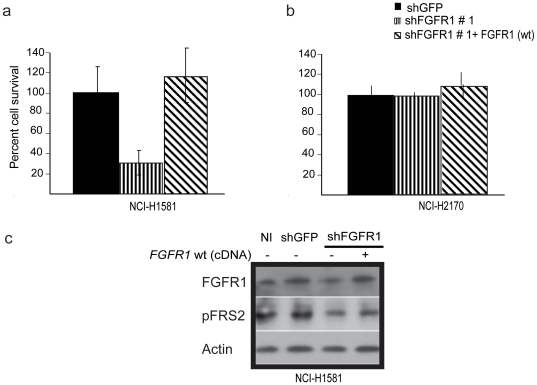
Ectopic expression of FGFR1 coding region rescues lethality of an shRNA targeting the FGFR1 3′ UTR.(A) Bar graph for rescue assay. Lethality due to depleted levels on endogenous FGFR1 level in NCI-H1581 is rescued by over expression of wild type (Wt) full length FGFR1 coding sequence . (B) No effect on the survival of NCI-H2170 cells was observed due to over expression of wild type form of FGFR1. NCI-H2170 is not dependent on FGFR1 activity. NI, no infection. shGFP, control hairpin specific for green fluorescent protein used as a negative control. All results are normalized to survival of cells infected with shGFP. Data shown is as mean of three replicates. (C) Validation of FGFR1 rescue by immunoblotting. Depleted levels of endogenous FGFR1 level in NCI-H1581 cells infected with FGFR1 shRNA-expressing lentiviruses targeting the FGFR1 3′UTR (lane 1) is rescued by overexpression of wild type form of FGFR1 cDNA lacking the 3′UTR (lane 2) with concomitant modest rescue in the levels tyrosine residue phosphorylation of the FGFR1 substrate FRS2 (middle panel). Actin is shown as a loading control (lower panel).